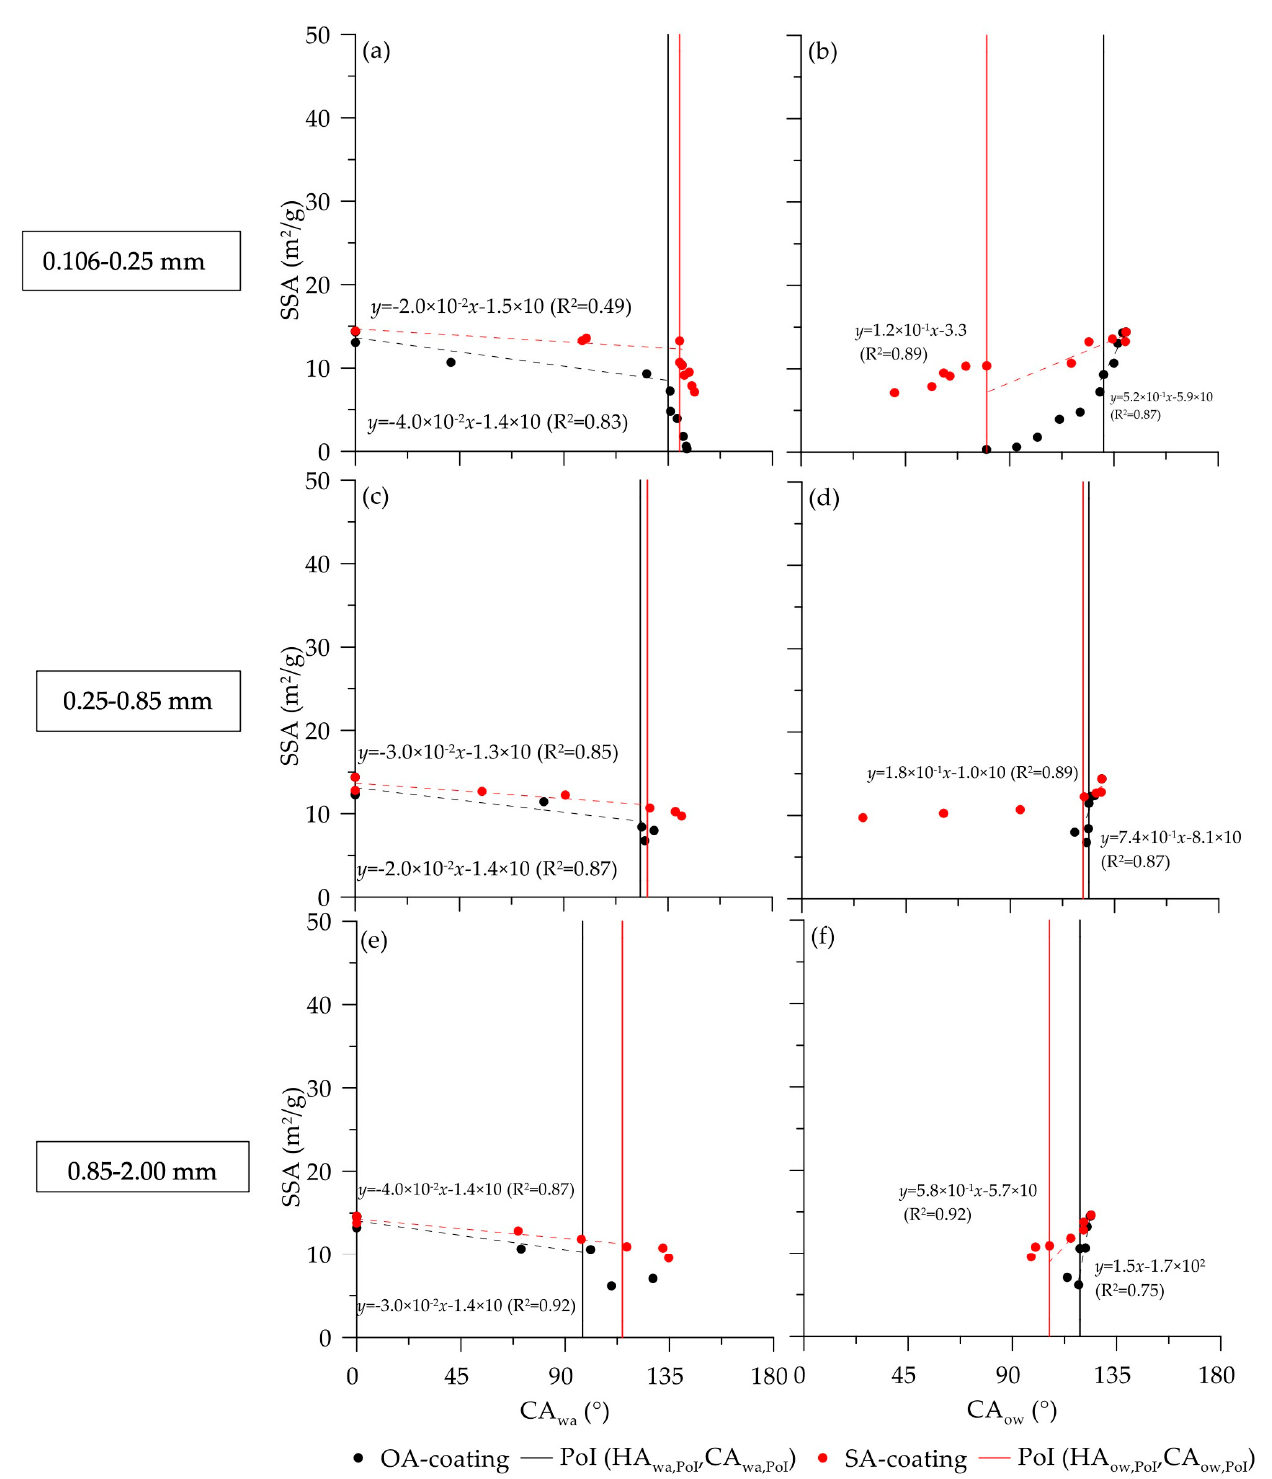
Figure 6. Relationships between SSA and CA wa /CA ow for OA- and SA-coated VN-AAC grains. OA-coated VN-AAC grain: ( a , b ) Grain size = 0.106–0.25 mm, ( c , d ) Grain size = 0.25–0.85 mm, and ( e , f ) Grain size = 0.85–2.00